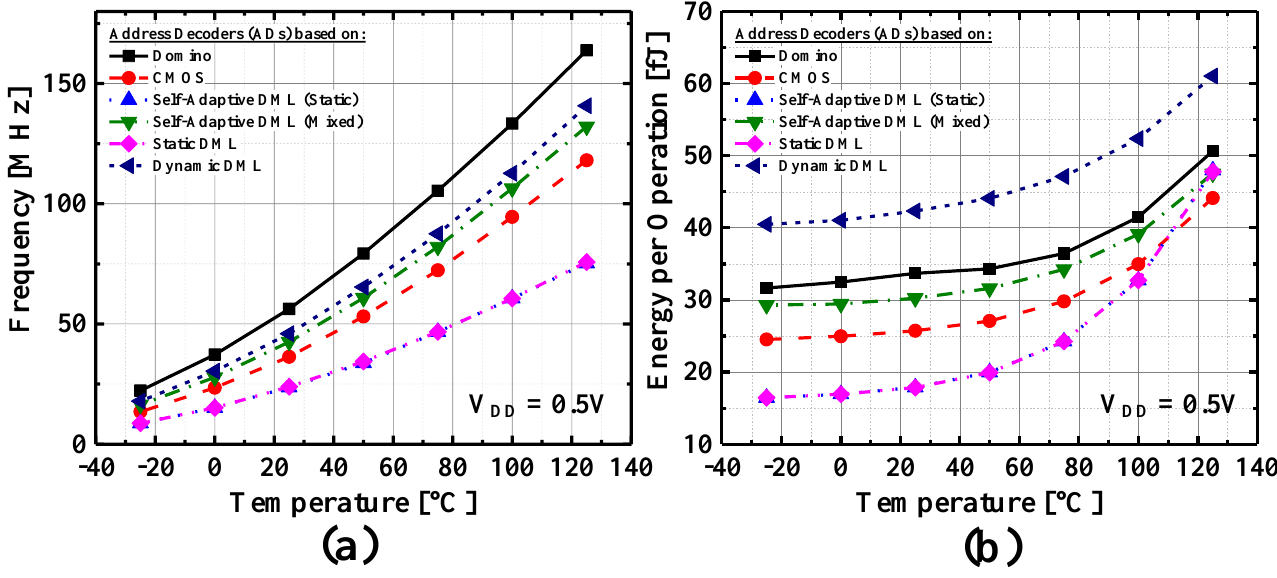
Figure 7. Address Decoder temperature variation analysis from − 25 ◦ C to 125 ◦ C at 0.5 V for: ( a ) Frequency. ( b )